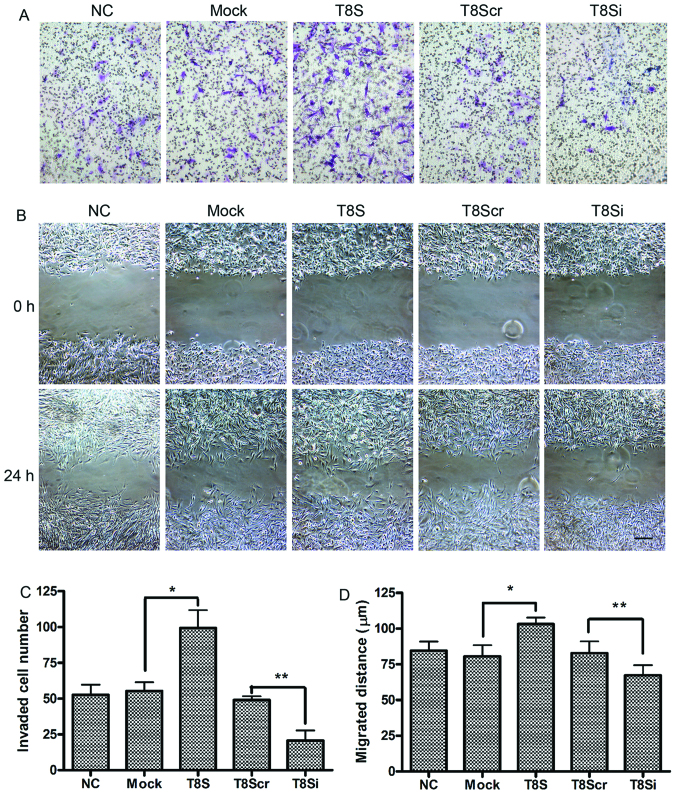
Cell metastatic capability detection. (A) Represent photomicrographs showing invasive capability of U251 cells in a chemoinvasion chamber (×200 magnification). (B) An injury line was made on a confluent monolayer of cells. Cell motility was examined with a light microscope (magnification, ×40) at the indicated time-points (0 and 24 h). (C) The number of migrating cells was determined by counting the stained cells and histogram. (D) The wounding area was quantified. *P<0.05 compared to the Mock group; **P<0.05 compared to the T8Scr group.